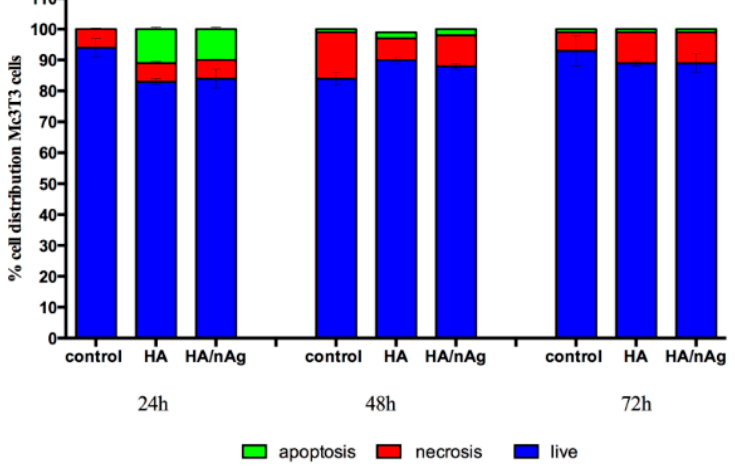
Figure 9. Tali image cytometry results performed with MC3T3-E1 cells.